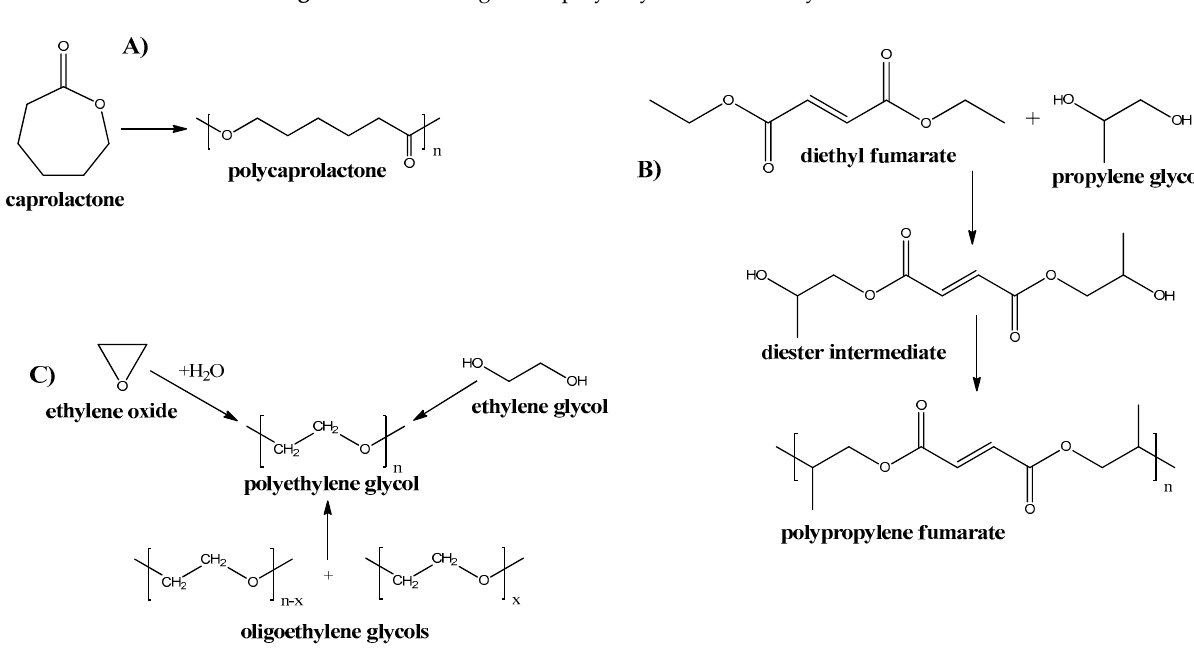
Figure 6. Synthesis routes of some petrochemical derived biodegradable plastics. ( A ) Poly- ε -caprolactone; ( B ) Poly-propylene Fumarate; and ( C ) Poly-ethylene Glycol.